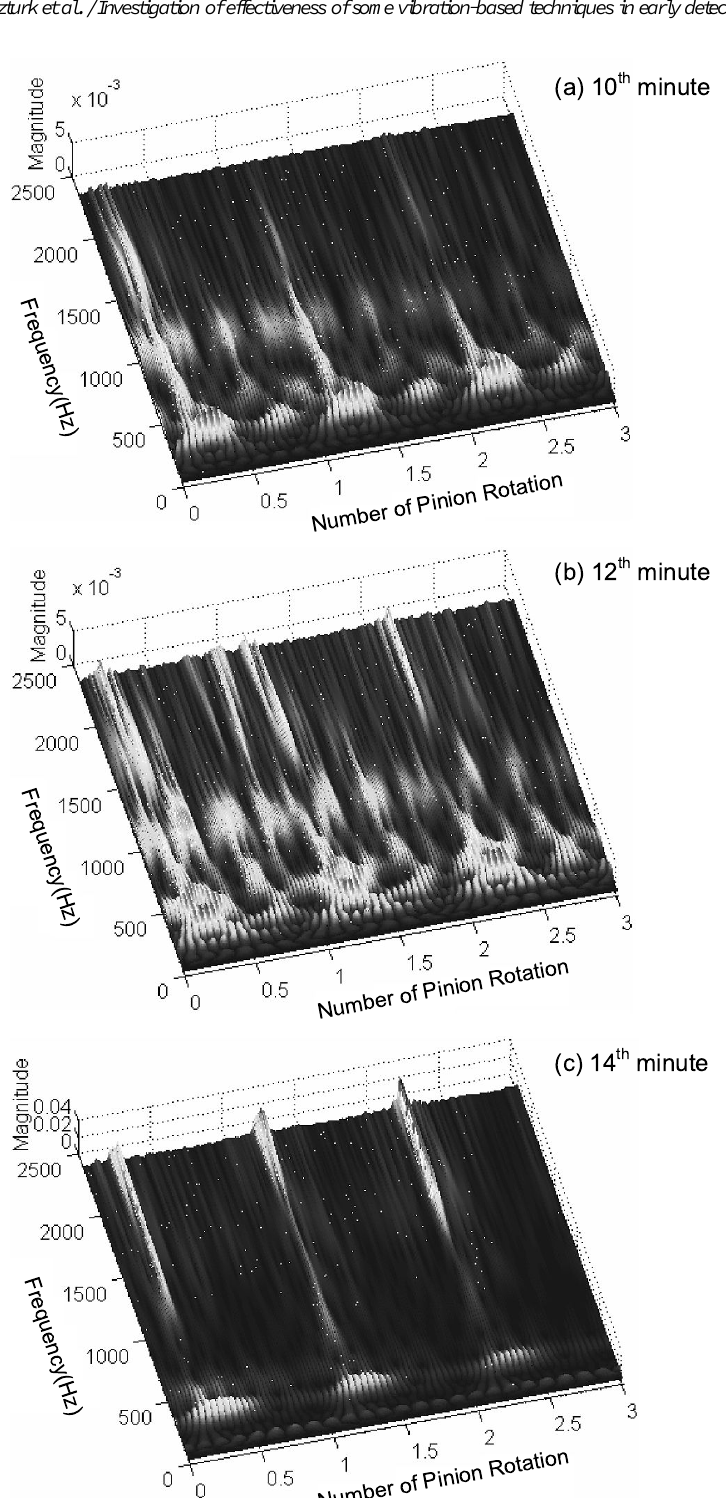
Fig. 14. Maps of wavelet transforms of the gear vibrations between 10–14